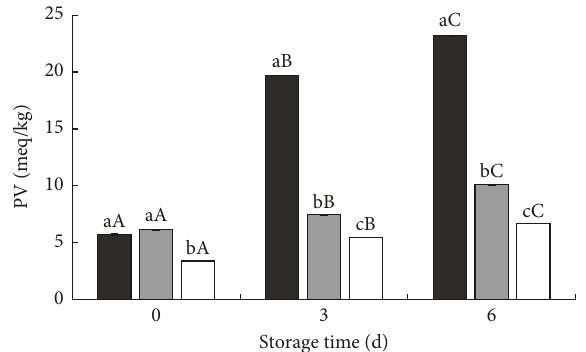
Figure 5: Peroxide values (PVs) of the emulsions with different oil contents ( oil: 5g/100 g; oil: 10g/100g; oil: 20g/100g) during storage. Different lowercase letters above bars indicate significant differences among samples of different oil contents, and different uppercase letters above bars indicate significant differences among samples of different storage times ( p < 0 . 05).